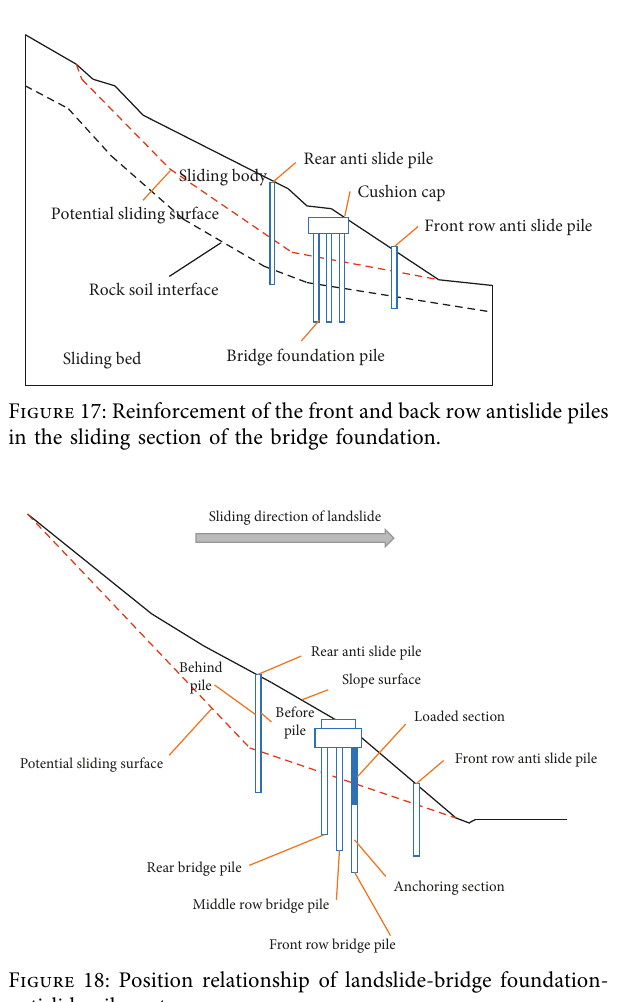
Figure 16: Reinforcement of the front and rear antislide piles in the antislide section of the bridge foundation.